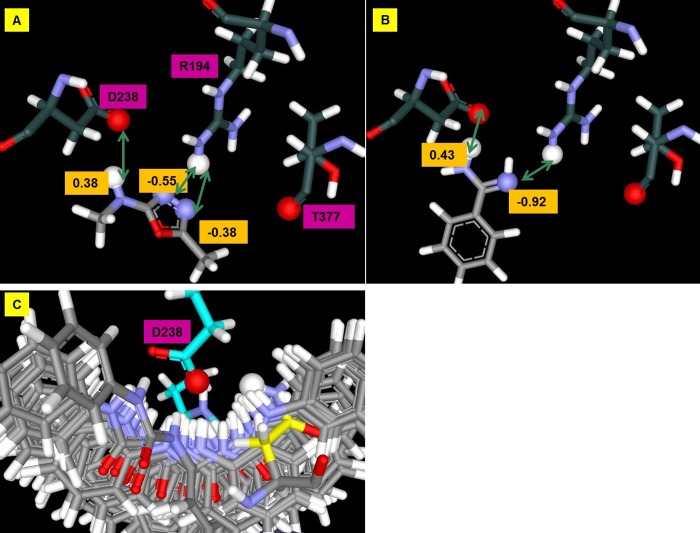
Much of the PCSK9 surface that interacts with LDLR is flat and featureless.Low affinity nondescript binding occurs with fragments like (A) dimethyl-oxadiazole and (B) benzamidine based on polar interactions (partial atomic charges shown in orange boxes) with R194-D238. The site is so highly exposed (C) that N,N’-diphenyl-urea can approach D238 from all directions.